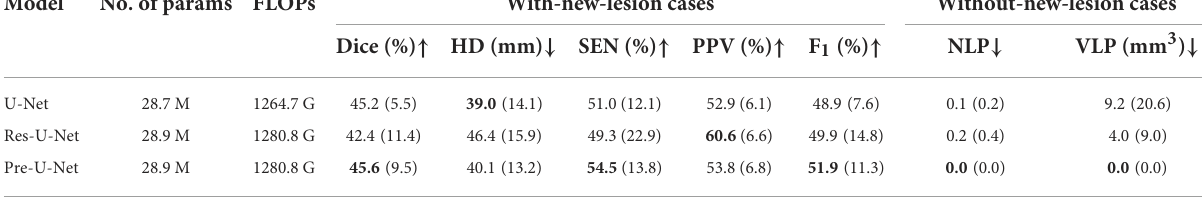
TABLE 2 Results obtained by five-fold cross-validation on the MSSEG-2 training set. Model